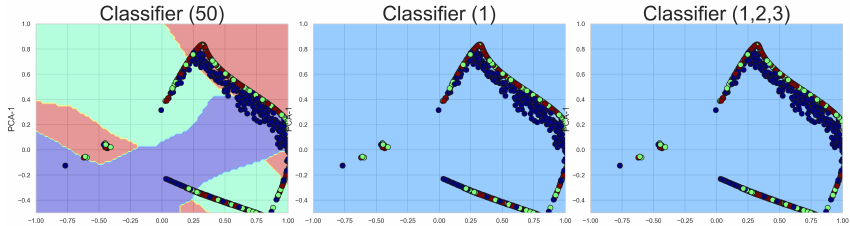
Figure 22. Fault Visualization plot aided with PCA for all dataset (CS, ESR, DF, Z).